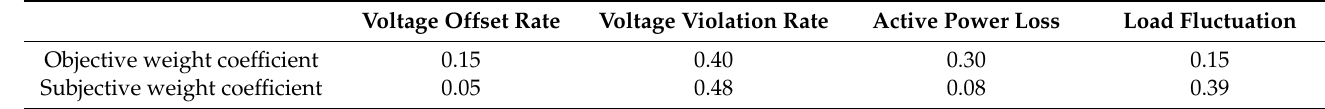
Table 8. Combined weighting coefficient of road network.